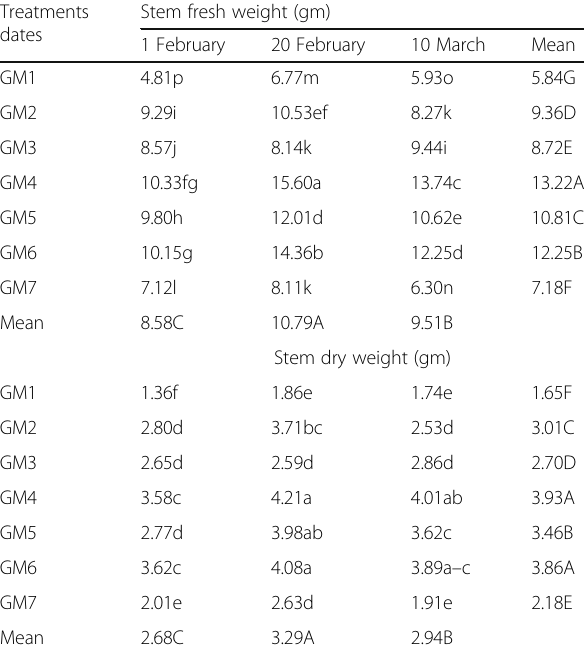
The same letter with row indicates that there is no significant difference ( p <